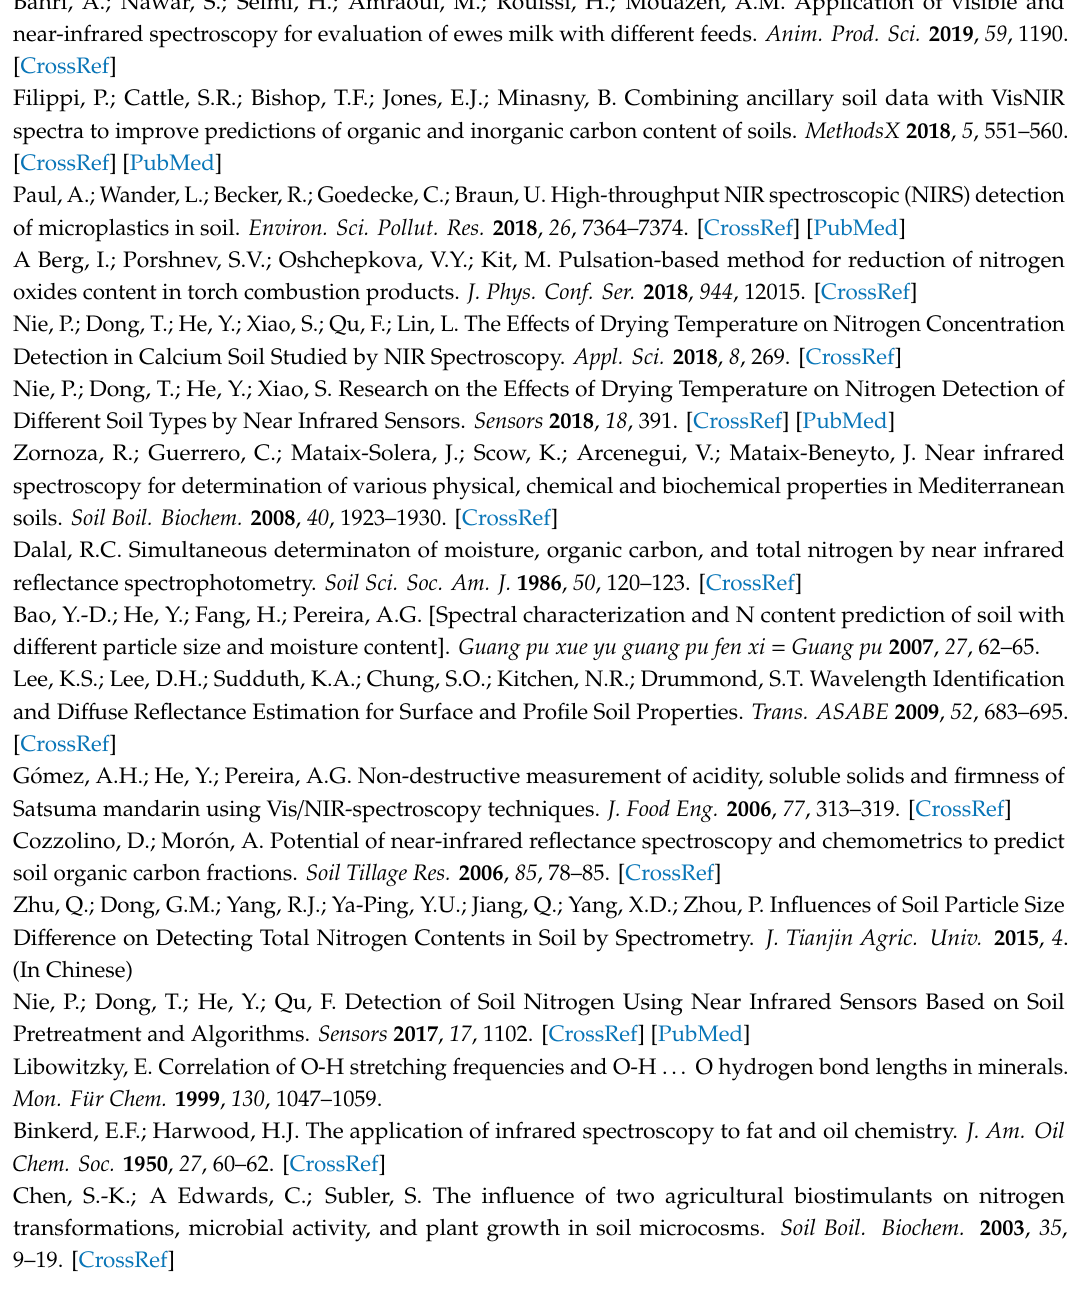
Supplementary Materials: Supplementary Materials are available online, Table S1: The CARS-PLS model prediction of di ff erent soil particle sizes Table S2: The bi-PLS model prediction of di ff erent soil particle sizes. Table S3: The GA-PLS model prediction of di ff erent soil particle sizes. Table S4: The SPA-PLS model prediction of di ff erent soil particle